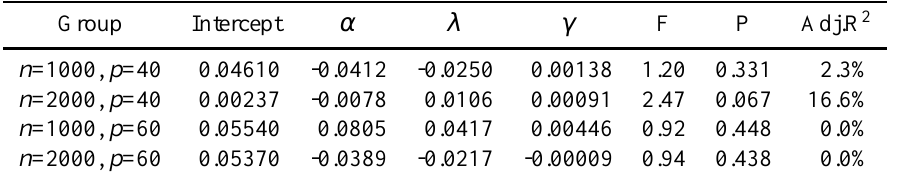
Table 3. Linear regression